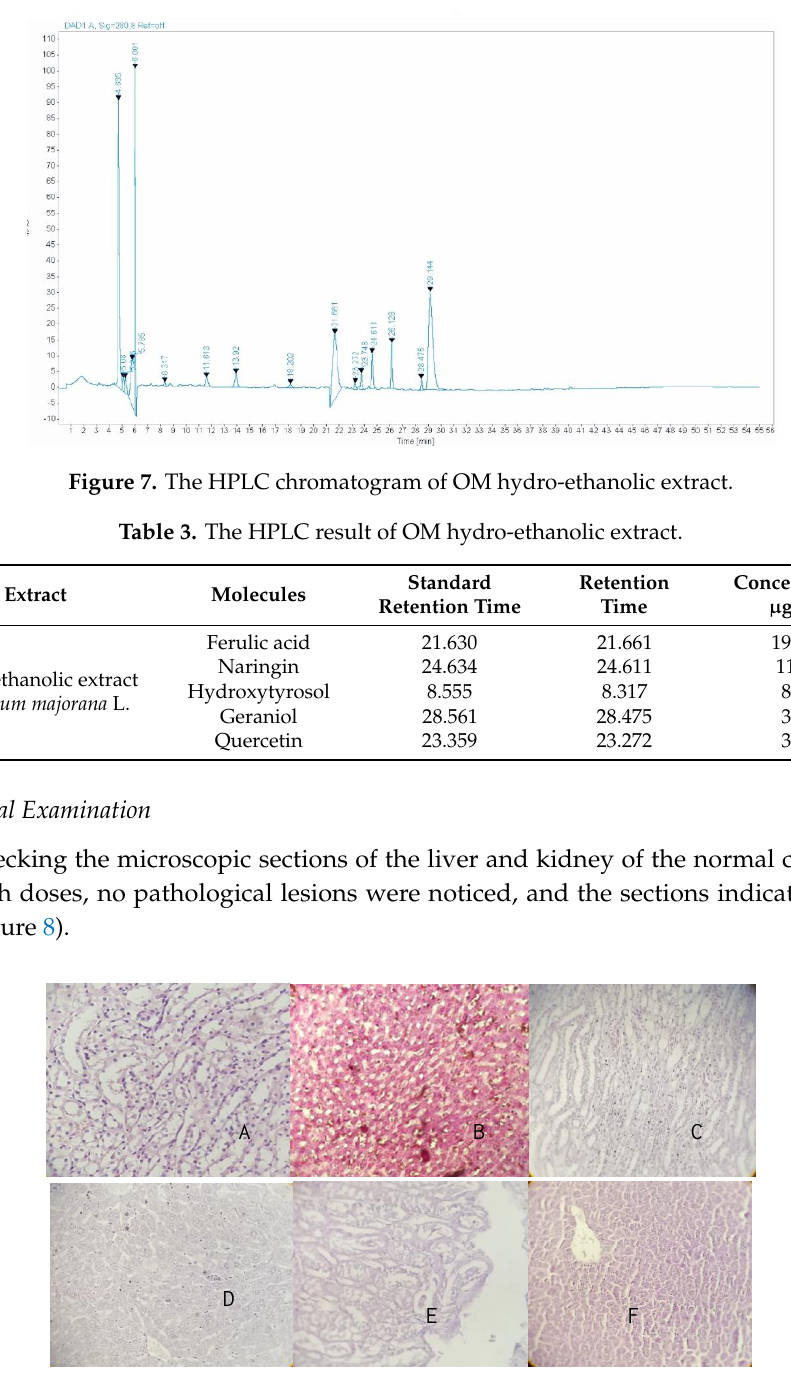
Figure 8. Histopathological examination of various organs of the mouse in oral toxicity study; ( A , B ) are liver and kidneys of the control group; ( C , D ) are kidney and liver of the group treated with OM at the dose of 250 mg / kg. ( E , F ) are kidney and liver of the group treated with OM at the dose of 500 mg / kg. ( A and B ) normal cells ( C ) normal cells ( D and F ), respectively, showing a normal arrangement of hepatocytes, mild inflammation, normal histological architecture with the central vein ( E ) shows some tubular degeneration (haematoxylin and heosin, ( H and E ) ×400).